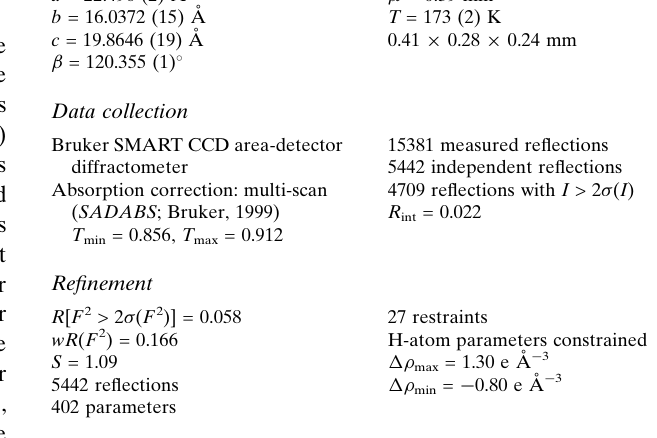
Experimental Crystal data